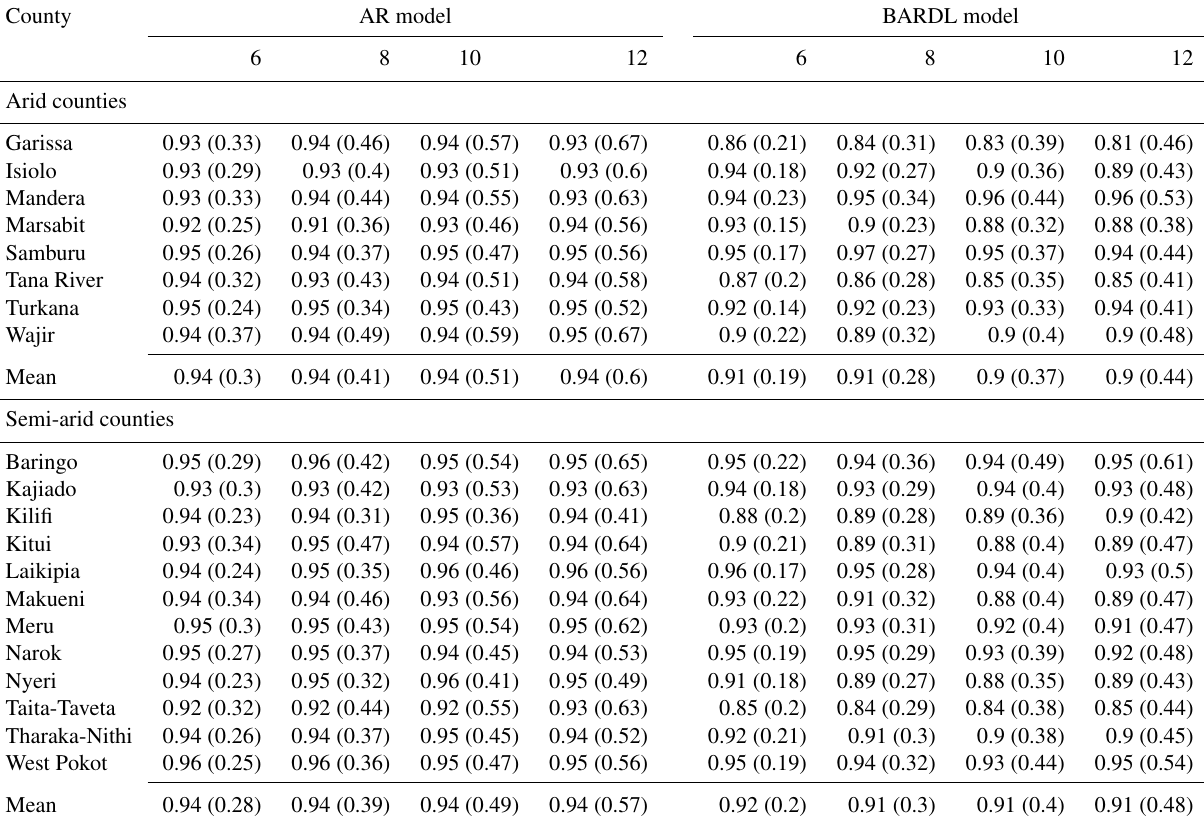
Table A1. The PICP and MPIW (in parentheses) estimates for all arid and semi-arid